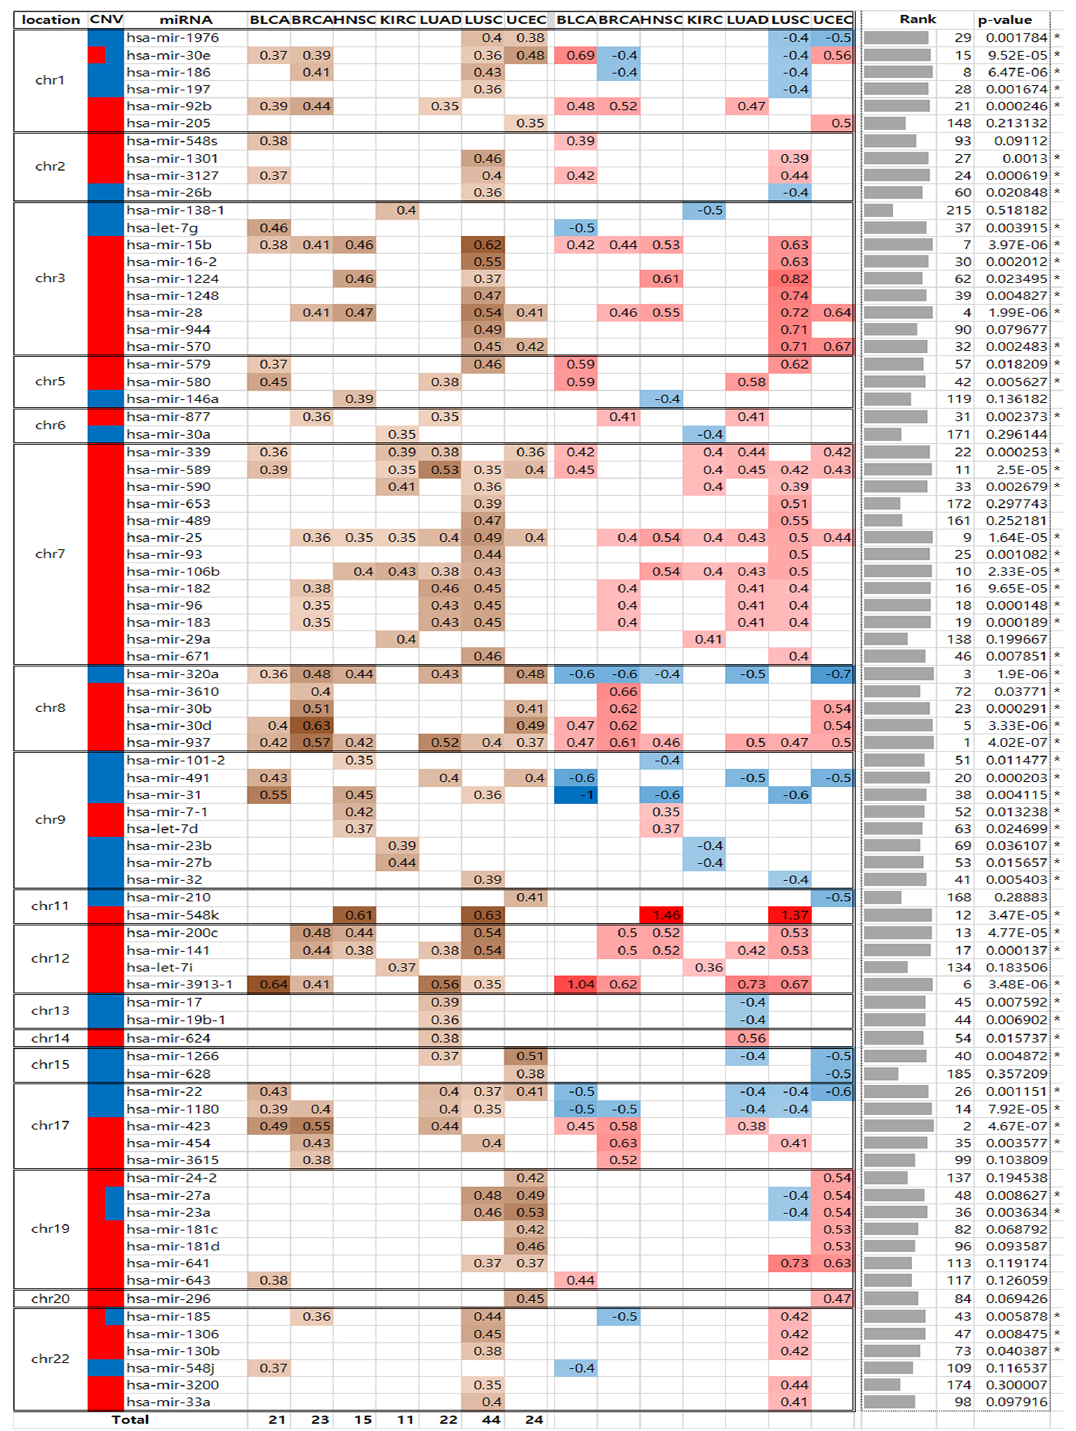
Figure 3. SCNA-miRNA heatmap obtained for seven cancer types. MiRNAs are listed according to their chromosomal locations. The PCC value, copy number state, and miRNA rank with p -value for each miRNA are shown (*, p -value < 0.05). The brown color intensities represent the degree of PCCs between miRNA copy numbers and expression levels, and red or blue intensities represent the average copy number values of samples amplified or deleted for the given miRNA and cancer type. The last row shows cancer-specific SCNA-miRNA